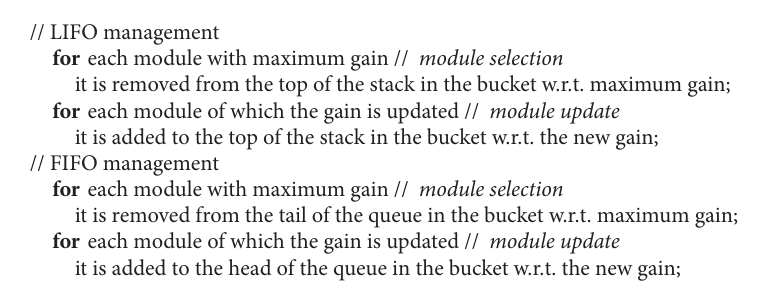
Algorithm 2: Pseudocodes of LIFO and FIFO management of gain